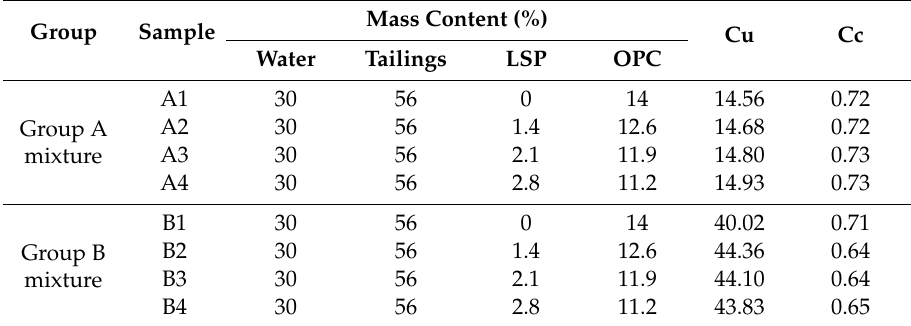
Table 2. Slurry ratio and size parameter of each group. LSP: limestone stone powder; OPC: ordinary Portland cement.